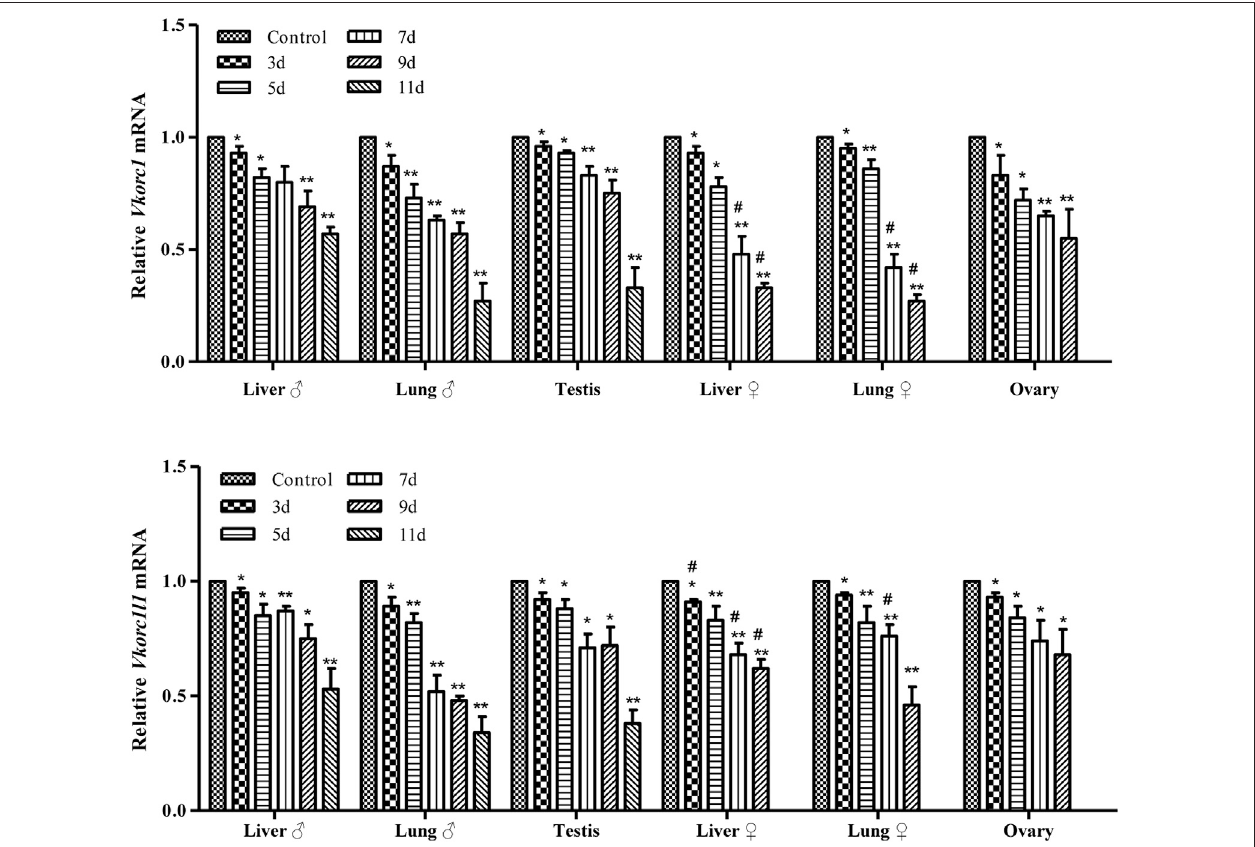
FIGURE 2 | The mRNA levels of Vkorc1/Vkorc1l1 genes in rats treated with Na-DHA. The relative quanti fi cation was used in qRT-PCR analysis. The Vkorc1/ Vkorc1l1 gene expression in rats treated with 200 mg/kg Na-DHA was normalized with the control in three parallel experiments with triplet replications. * p < 0.05, ** p < 0.01, compared with the normal control; # p < 0.05, the same tissue in the female and male rats compared at the same